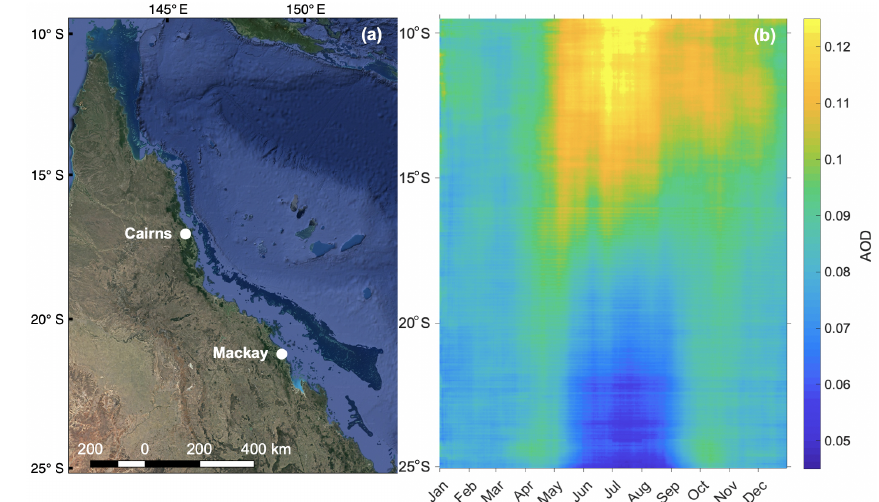
Figure 6. (a) Map of the GBR, Australia (map data © 2019 Google), showing the region defined in (b) longitude-averaged Hovmöller plot of daily mean (2001–2017) total AOD (869nm) over the GBR.